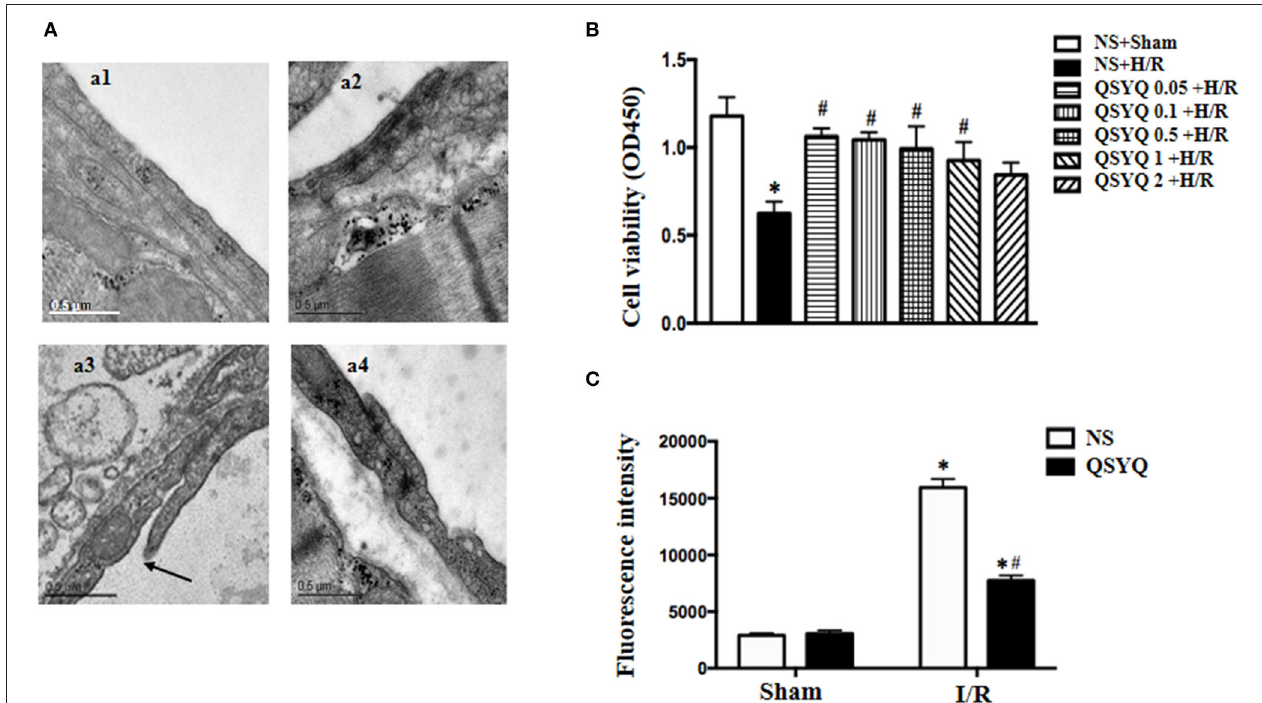
FIGURE 2 | Effect of pretreatment with QSYQ on cardiac microstructure in rats and viability and endothelial barrier integrity of HCMECs. (A) Representative electron micrographs of cardiac vascular endothelium in different groups. a1: NS + Sham group; a2: QSYQ + Sham group; a3: NS + I/R group; a4: QSYQ + I/R group. Arrow: intercellular gap. Bar = 0.5 µ m. (B) Viability of HCMECs challenged by H/R with or without various dosages of QSYQ. Statistical analysis was performed using one-way ANOVA followed by Newman–Keuls test. (C) Effect of QSYQ on hyperpermeability of HCMEC monolayer challenged by H/R. The permeability was expressed as the optical density at 492nm of FITC-dextran in the lower chamber. Data are expressed as means ± SEM ( n = 6). * p < 0.05 vs. NS + Sham group or control group, # p < 0.05 vs. NS + I/R group. Statistical analysis was performed using two-way ANOVA followed by Bonferroni for multiple